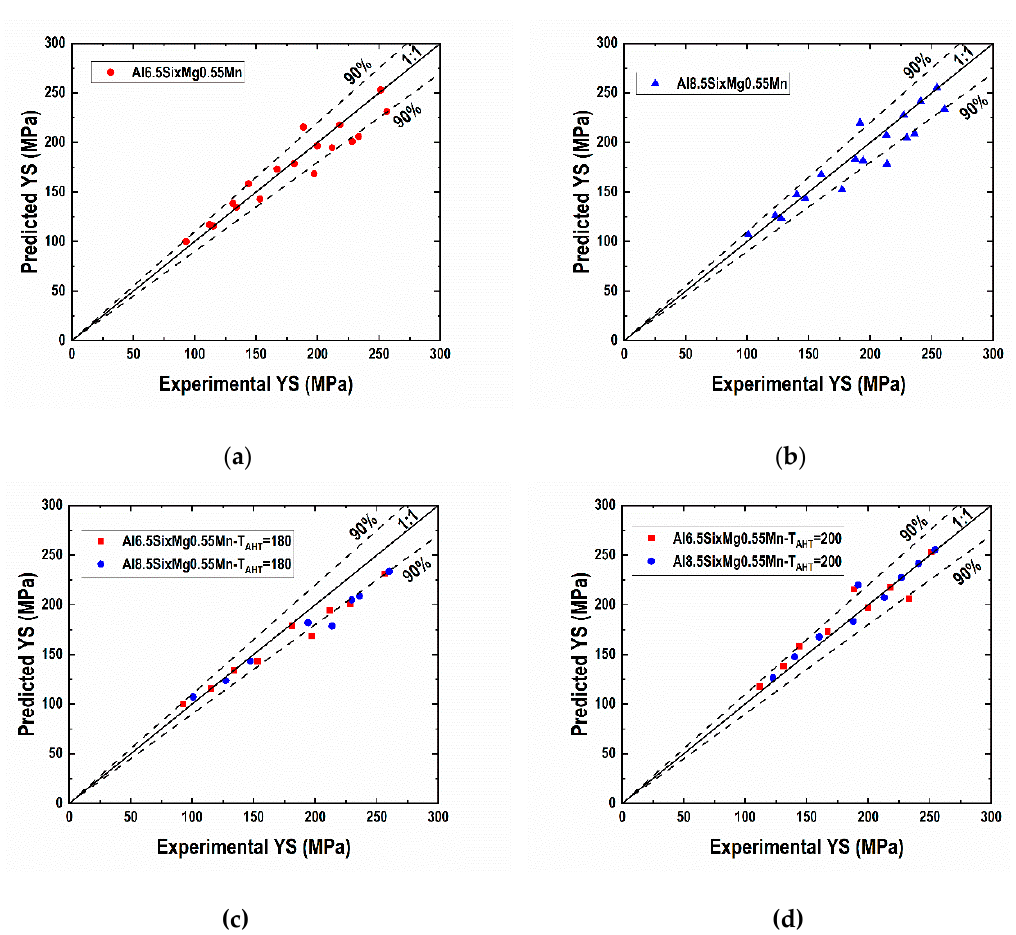
Figure 4. The application of the optimized model to the industrial alloy and comparison of experimental and predicted yield strength for: ( a ) low Si (6.5 wt.%) alloy set; ( b ) high Si (8.5 wt.%); ( c ) aging temperature of 180 °C; and ( d ) aging temperature of 200 °C.